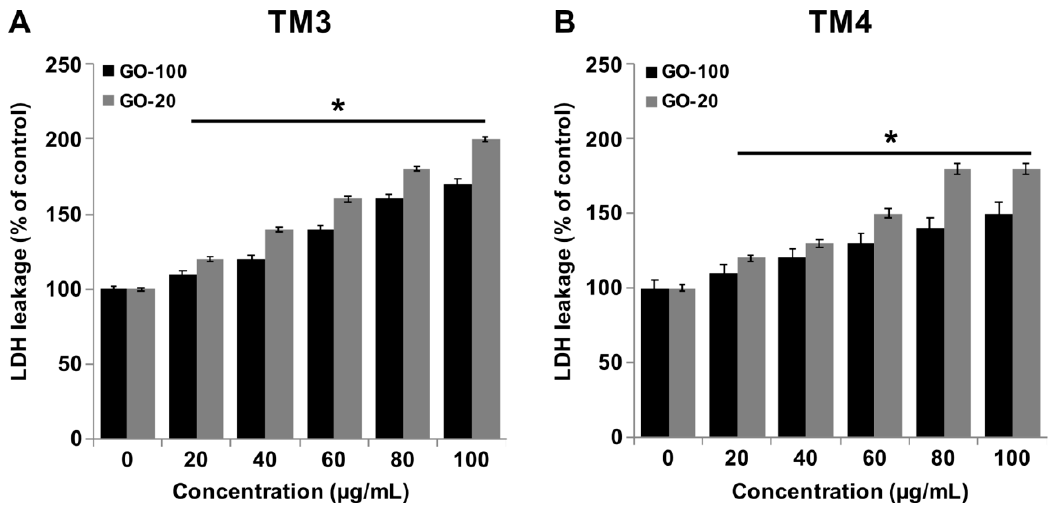
Figure 4. GO-100 and GO-20 graphene sheets increase the leakage of LDH. ( A ) TM3 cells were treated with GO (20–100 μ g/mL) and GO-20 (20-100 μ g/mL) for 24 h, and LDH activity was measured at 490 nm using an LDH cytotoxicity kit. ( B ) TM4 cells were treated with GO (20–100 μ g/mL) and GO-20 (20–100 μ g/mL) for 24 h, and LDH activity was measured at 490 nm using